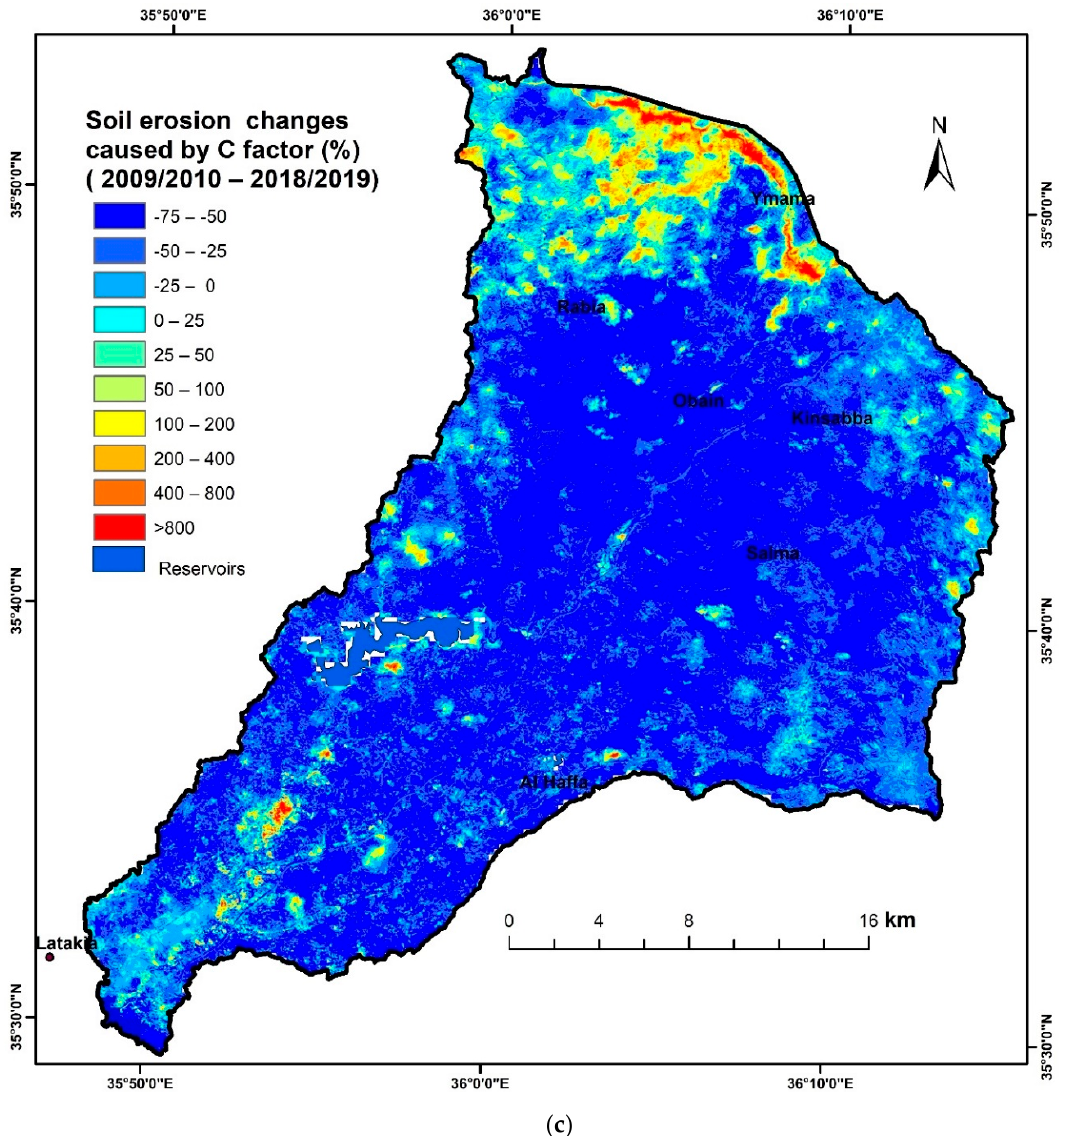
Figure 6. The effect of the C factor on the rate of soil erosion over different periods. ( a ) 2009 / 2010–2013 /